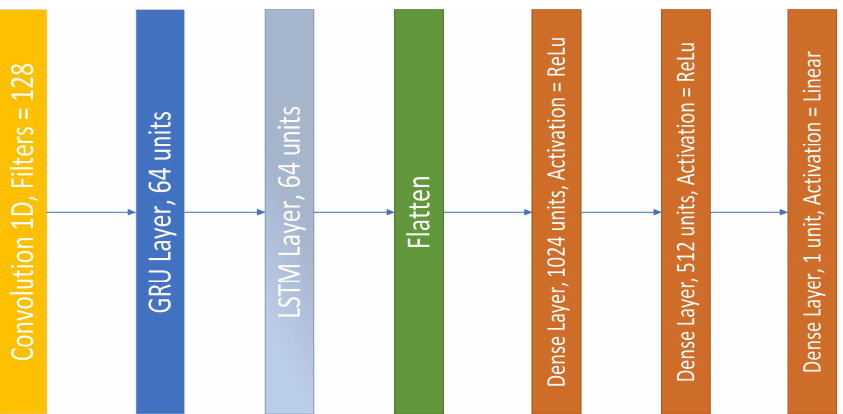
Figure 9. Architecture of the hybrid CNN-GRU-LSTM model.